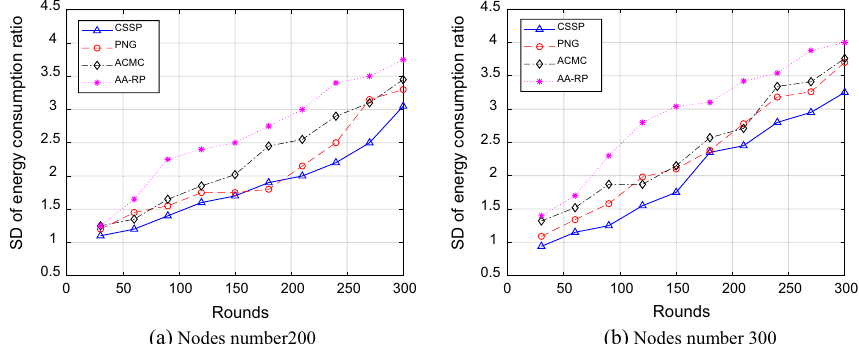
Fig. 7 Comparison of SD of energy consumption for different number of sensor nodes (a) Nodes number 200; (b) Nodes number